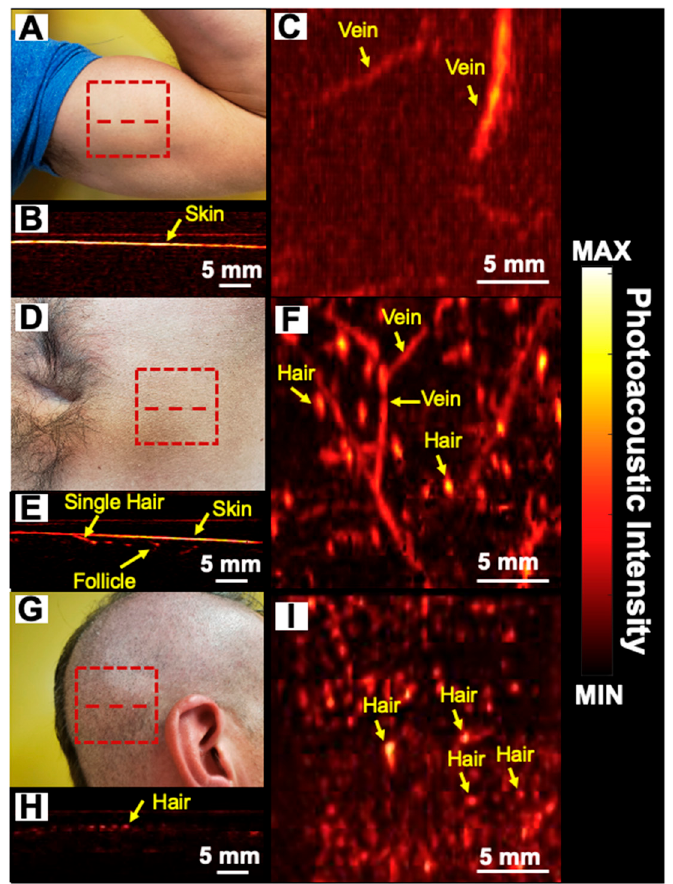
Figure 5. Follicular density images. ( A , D , G ) photograph; ( B , E , H ) cross-sectional photoacoustic image along the red dashed line. ( C , F , I ) maximum intensity projection (MIP) photoacoustic images of biceps, shaved stomach, and trimmed scalp using 850 nm LED light source within the 2 × 2 cm 2 area marked by red dashed rectangles, respectively. PAI shows the absence of hair on the biceps whereas subdermal hair follicles can be seen in the stomach and scalp regions. Vasculature close to the skin surface can also be imaged due to hemoglobin that absorbs at near-infrared wavelengths and produces photoacoustic signal.